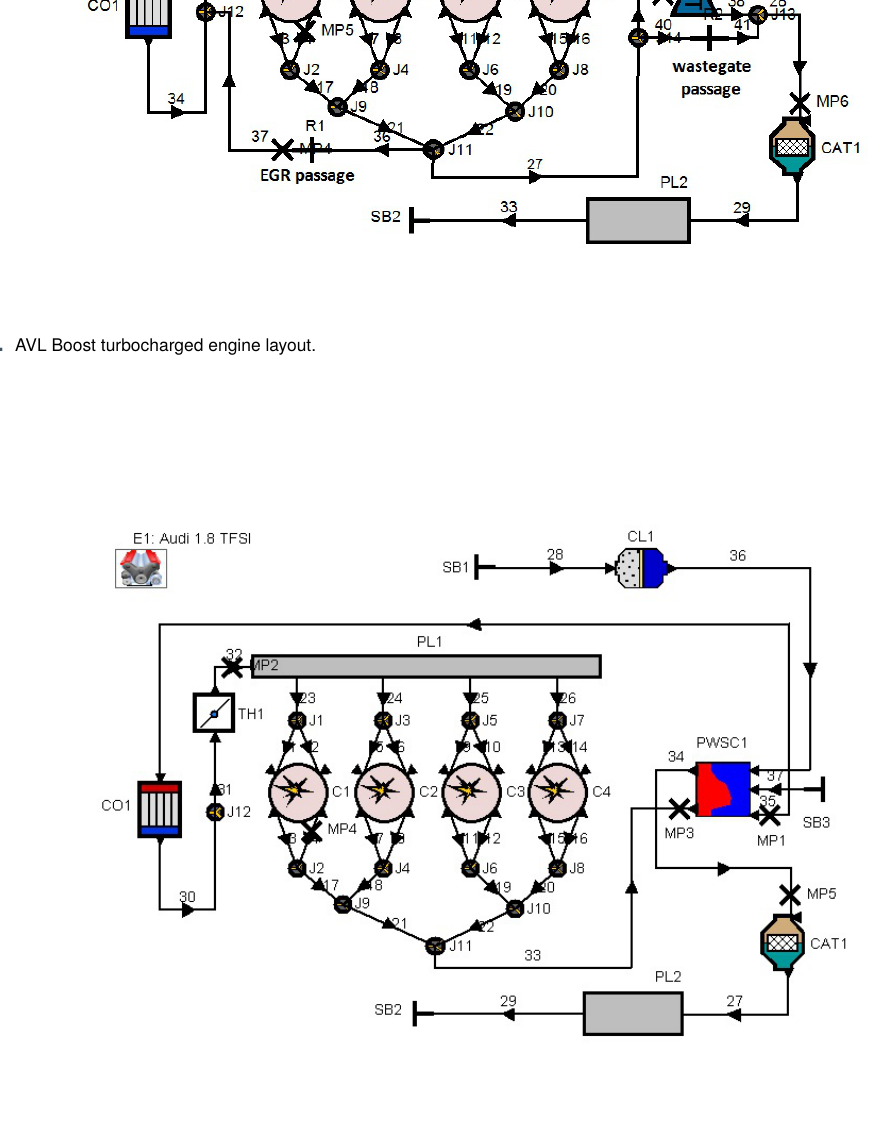
Figure 5. AVL Boost pressure wave supercharged engine